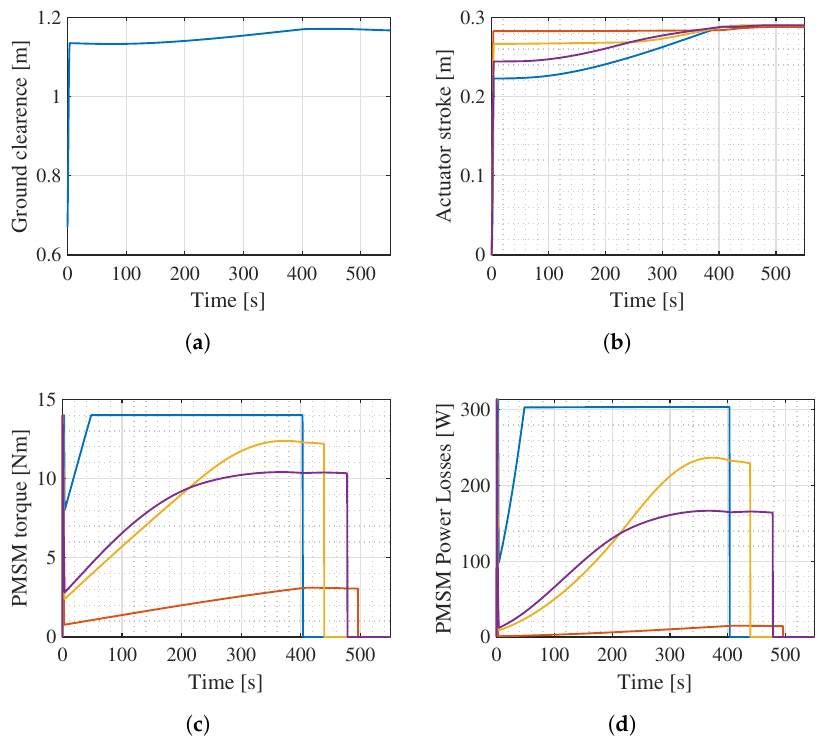
Figure 14. Leveling phase multi-body simulation for leg 1 (orange), leg 2 (yellow), leg 3 (blue) and leg 4 (violet), according to Figure 12b. ( a ) Vertical clearance between ground and lander module. ( b ) Ac- tuator stroke. ( c ) PMSM torque. ( d ) PMSM power